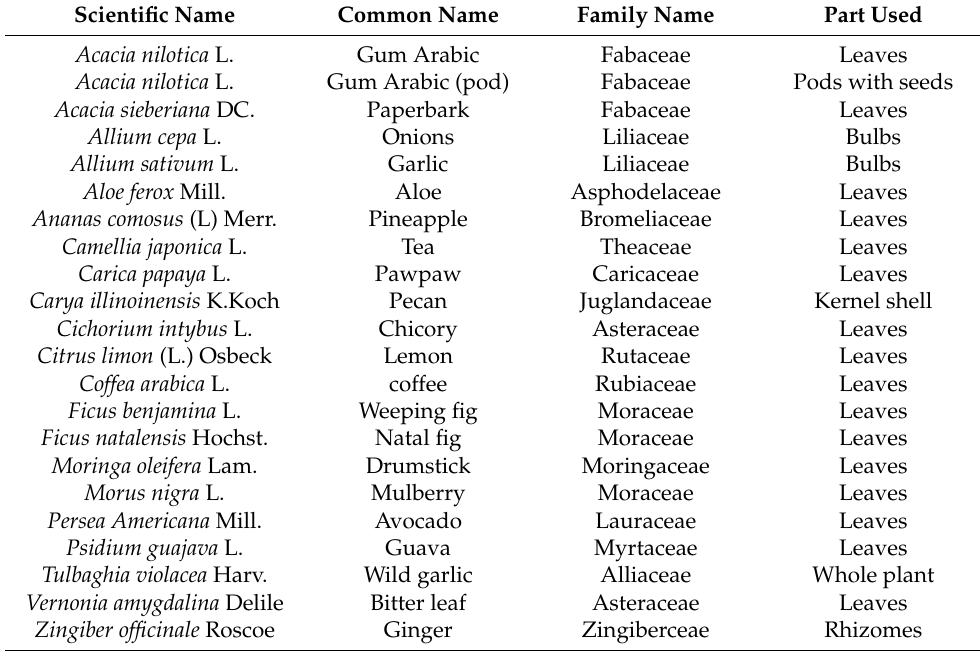
Table 1. List of plant species evaluated for their effect on rumen fermentation in